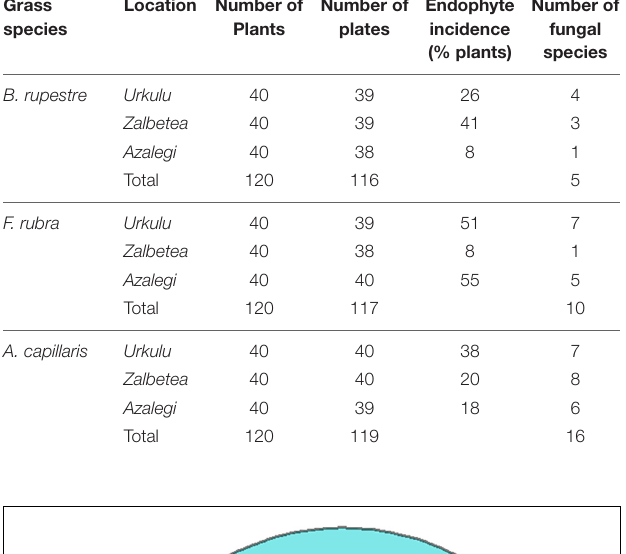
( Figure 4 ), but different endophyte assemblages ( Figure 2 and PERMANOVA analysis). Differences were mostly due to the different probability of incidence of the core taxa ( Figure 6